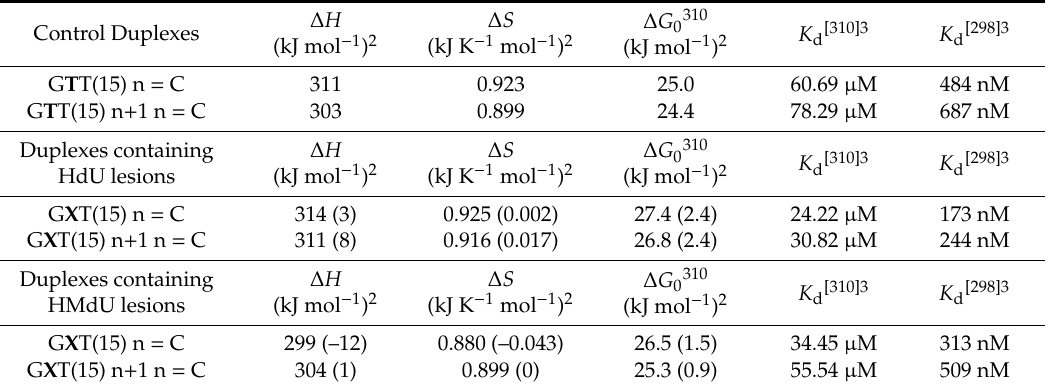
Table 3. MST-derived thermodynamic parameters of dissociation of duplexes formed between the 15mer DNA templates G T T(15) and G X T(15) (X = HdU or HMdU) and the matched or mismatched primers n or n + 1, where n = C nucleotide. 1.